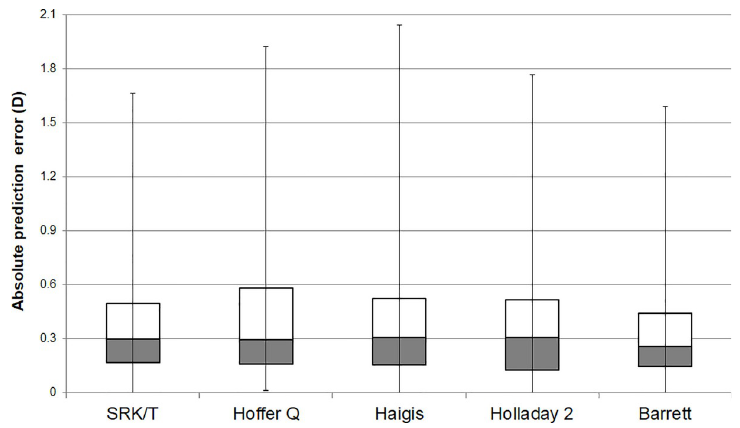
Fig 2. Box plot of the absolute error (in diopters) of the five intraocular lens (IOL) calculation formulas for the ZCB00 model. Dark gray boxes represent the second quartile, and white boxes represent the third